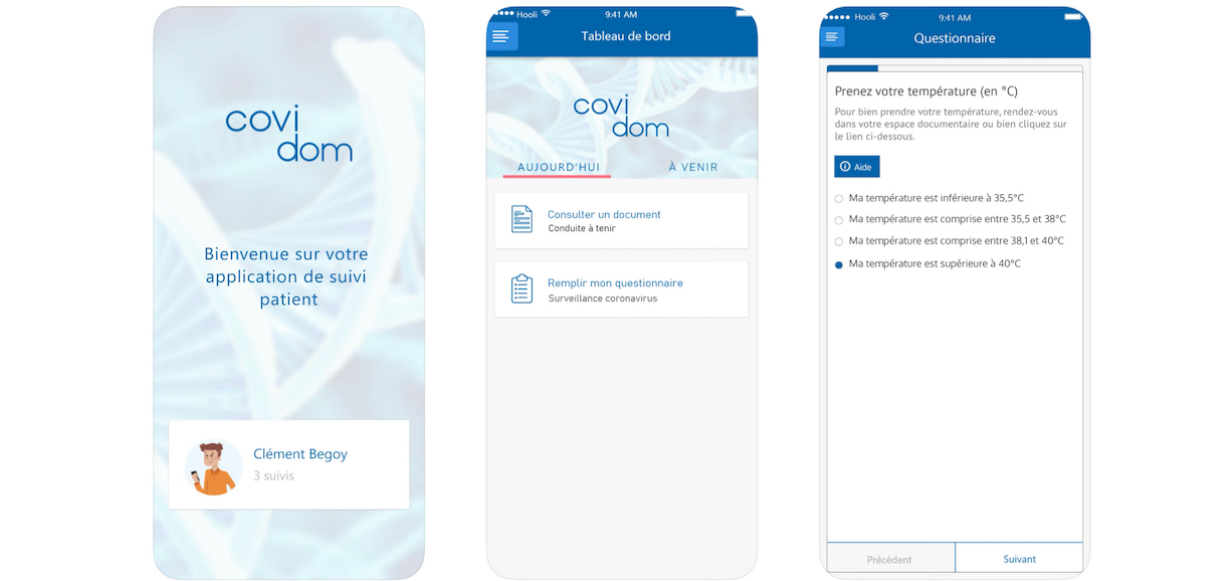
Figure 2. Covidom web application